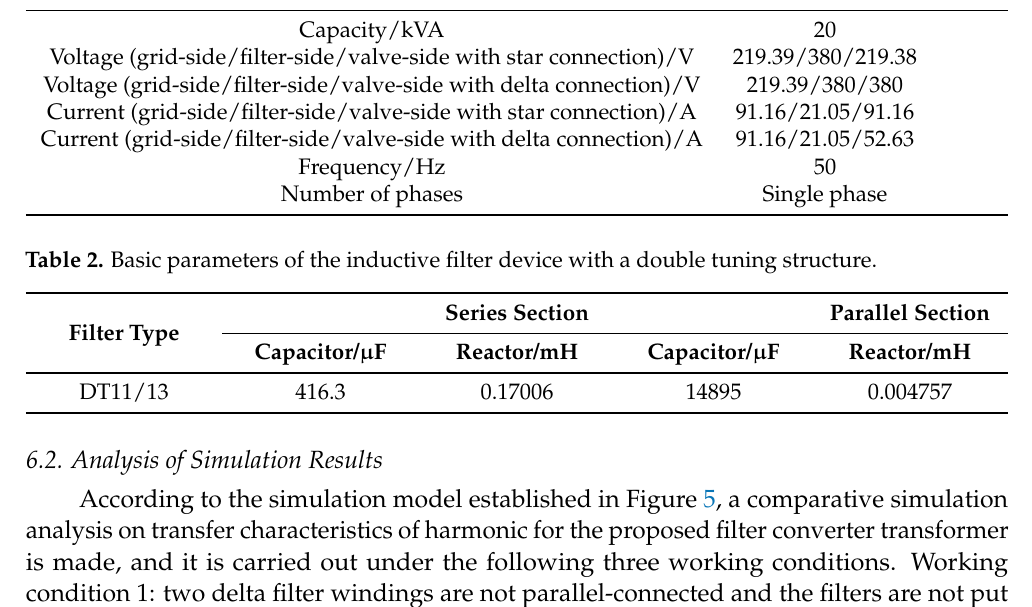
Table 1. Rated parameters of the novel single-phase inductive filter converter transformer. Rated Parameters